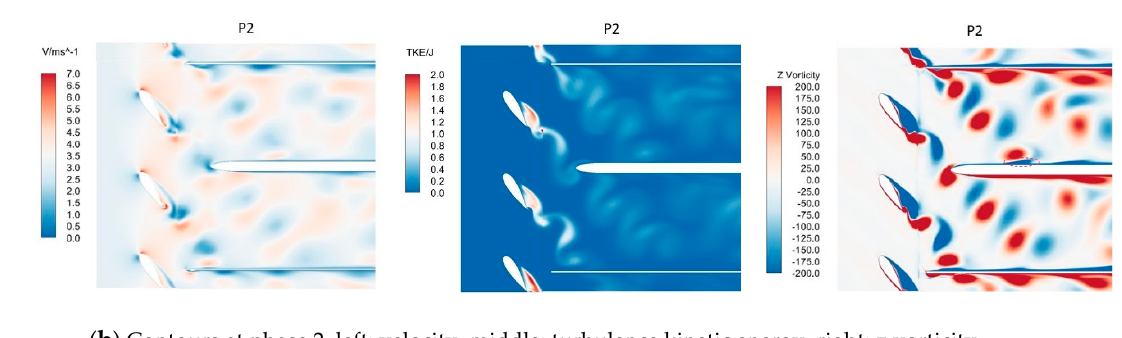
( b ) Contours at phase 2, left: velocity, middle: turbulence kinetic energy, right: z vorticity.